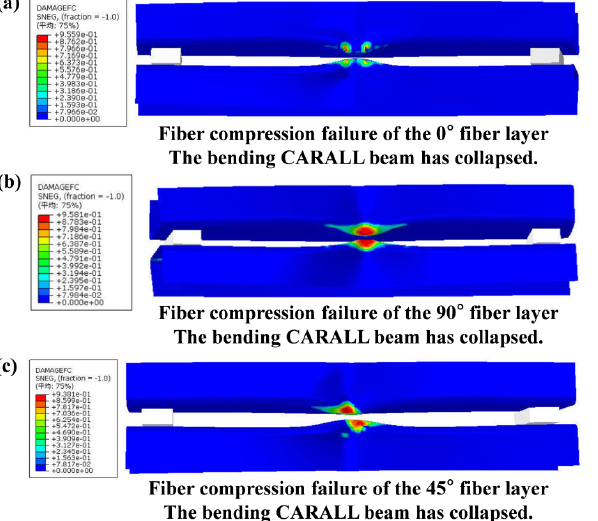
Figure 16: Failure evolution process of fiber compression in CFRP layers of double-channel CARALL beam: (a) SHCXL-A: 0 ∘ fiber layer; (b) SHCXL-A: 90 ∘ fiber layer; and (c) SHCXL-B: 45 ∘ fiber layer.